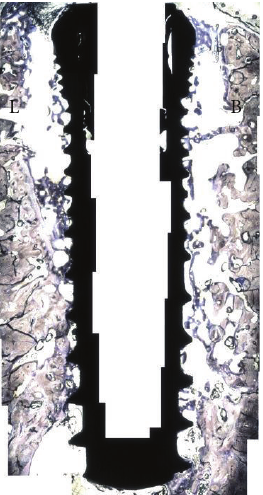
Figure 4: Merged optical micrograph depicting the experimental group, where the immediate implant placed at the mesial molar socket was covered with a resorbable membrane prior to suturing. For this group, extensive apical migration (arrows) did not occur at both buccal (B) and lingual (L) aspects resulting in osseointegration at higher levels relative to the control side. The red and blue boxes are described in detail in Figure 5.